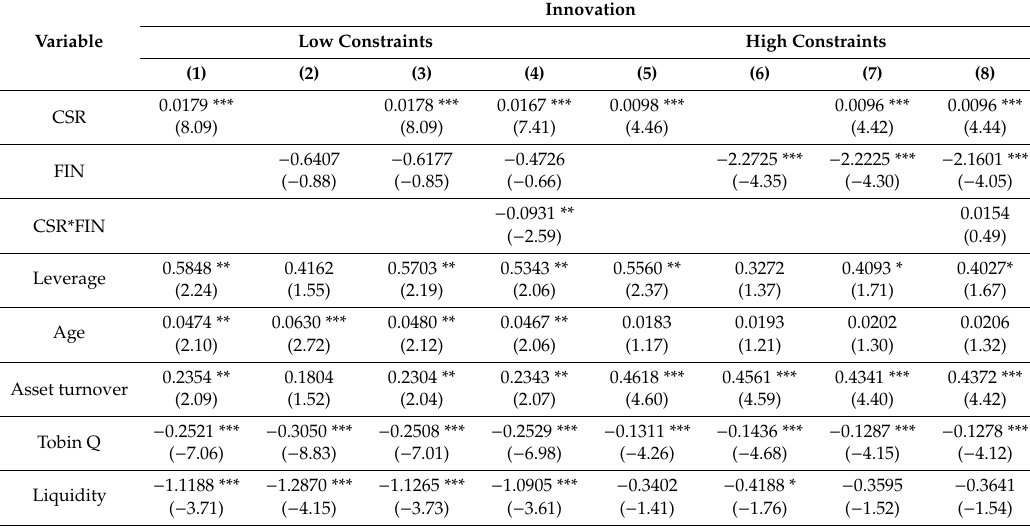
Table 6. Regression results of di ff erent